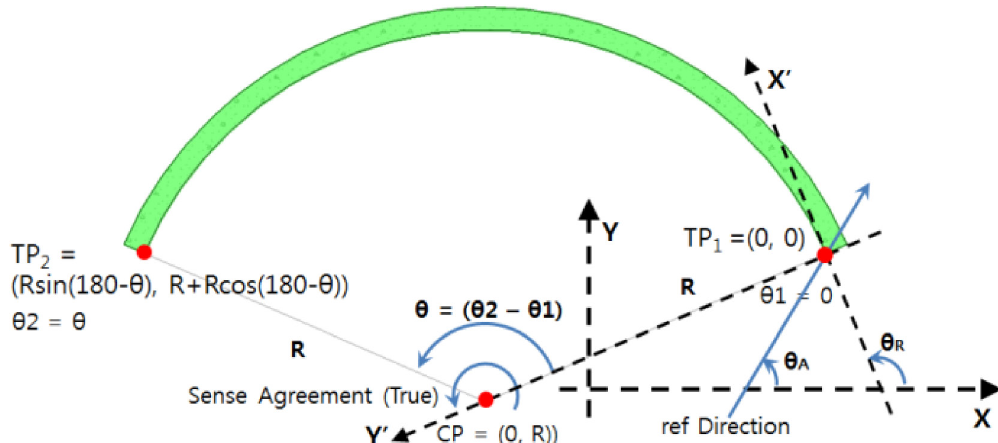
Fig. 1. Definitions of required data on proposed